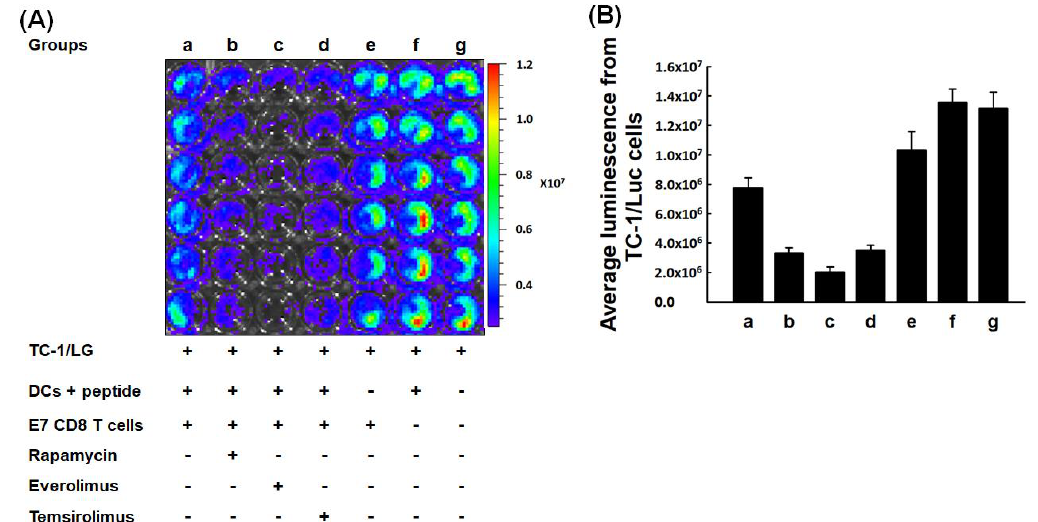
BMM-derived DCs ( p < 0.001, n = 3).